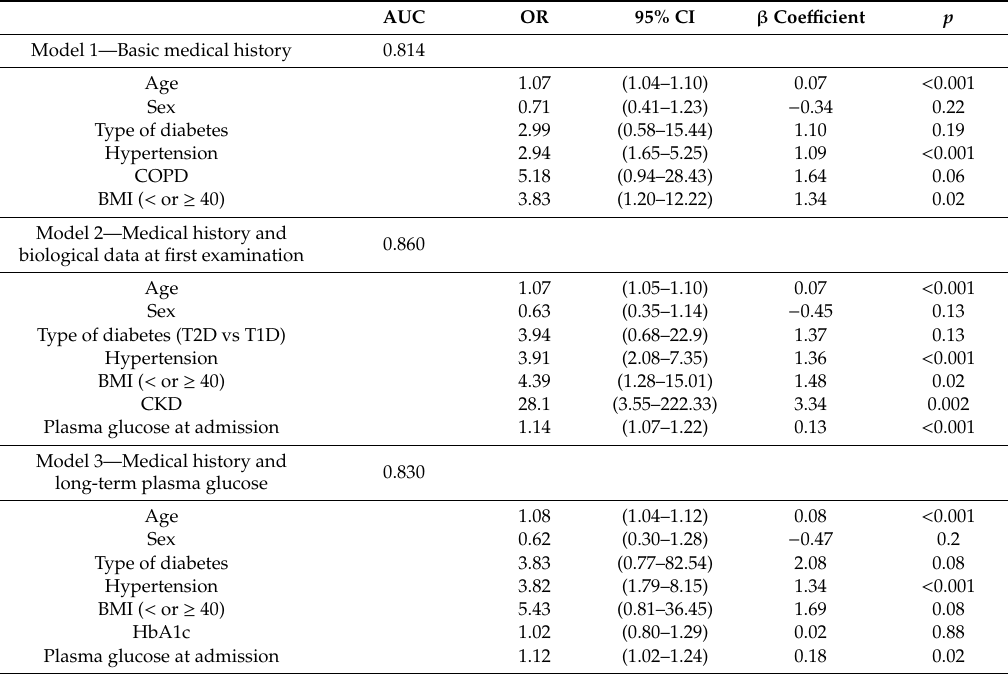
Table 3. Stepwise multivariate